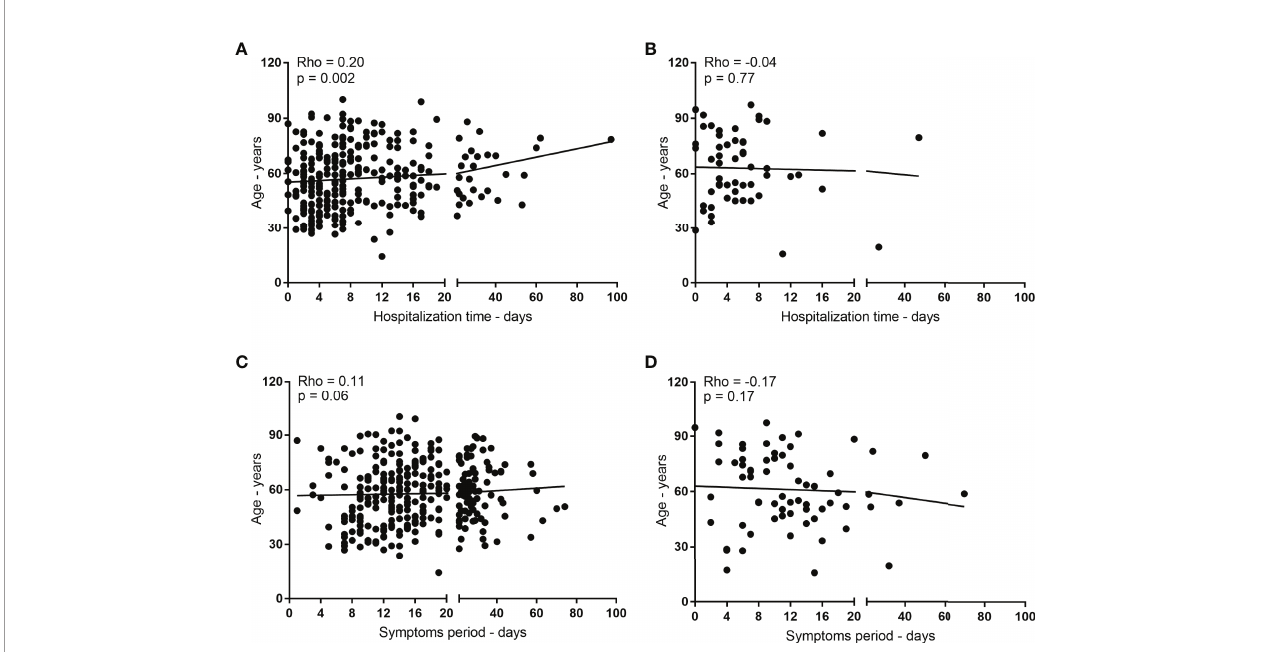
FIGURE 1 | In fl uence of age on the length of hospitalization and symptomatic period of patients with COVID-19. In (A, B) , correlation between age (years) and length of hospitalization (days) for positive and negative patients for COVID-19, respectively. In (C, D) , correlation between age (years) and period of symptoms (days) for COVID-19 positive and negative patients, respectively.